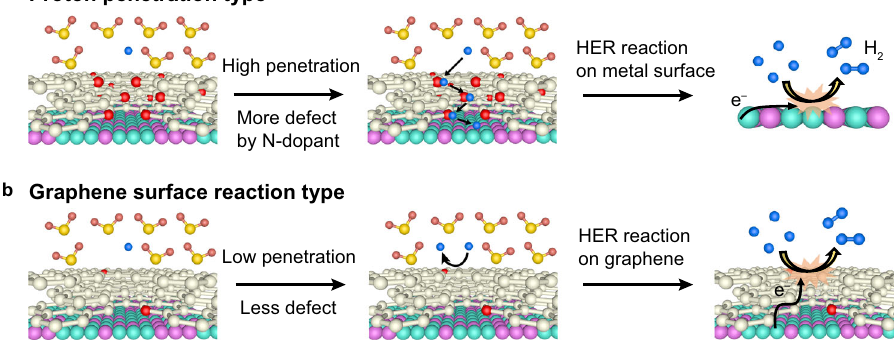
Fig. 6 Schematic HER mechanisms for graphene-covered non-noble metal catalysts. a Proton-penetration-type mechanism. Protons penetrate through the graphene covering layers, and H 2 evolution occurs on the surface of the underlying non-noble metal substrate. b Graphene-surface-reaction-type mechanism. The H 2 evolution occurs on the outermost graphene layer by utilizing charge transfer from the underlying non-noble metal substrate. Colour code: carbon (white), nitrogen (red), proton (blue), nickel (cyan), molybdenum (purple), oxygen (light yellow), and hydrogen